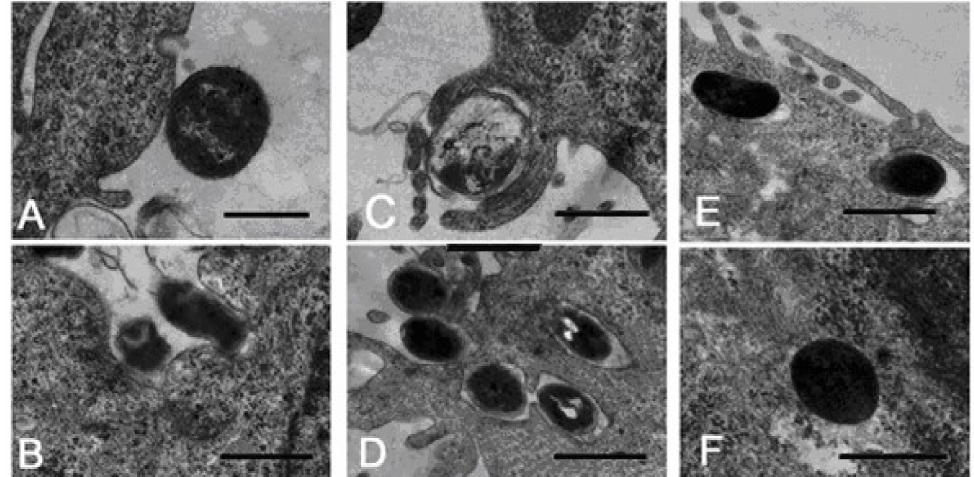
Figure 4. Electron microscopic identification of the initial steps in the invasion of eukaryotic cells by Serratia grimesii . ( A ) Tight contact of bacteria with HeLa M cells. ( B ) Extensive contact of bacteria with the surface of the host cell followed by the entry of bacteria into the host cell, which corresponds to the zipper mechanism of invasion. ( C , D ) Appearance of host cell filopodia, whose fusing traps bacterium and places it inside the vacuole, which corresponds to the trigger mechanism. ( E ) Bacteria live in the vacuoles. ( F ) Bacteria leave the vacuole to live free in the host cell cytoplasm. Scale bars, 1 µ m. (Modified from [50] with permission from Pleiades Publishing, Ltd. 117342,